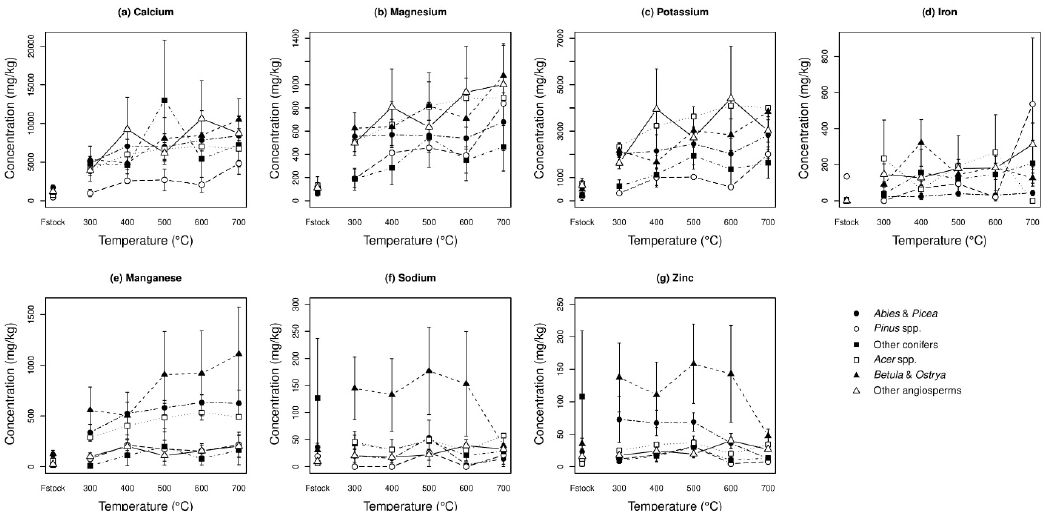
Figure 2. Inductively coupled plasma-atomic emission spectroscopy (ICP-AES) alkaline elements concentration plots of ( a ) Ca, ( b ) K, ( c ) Mg, ( d ) Fe, ( e ) Mn, ( f ) Na, and ( g ) Zn in 19 temperate tree species ( n = 9 conifers and n = 10 angiosperms) across pyrolysis temperatures of 300, 400, 500, 600, and 700 °C.